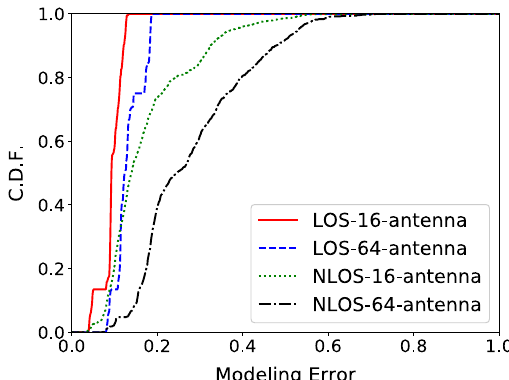
Fig. 7 Cumulative distribution function of modeling error with two different array sizes. The plot is based on measured line-of-sight and non-line-of-sight channels,